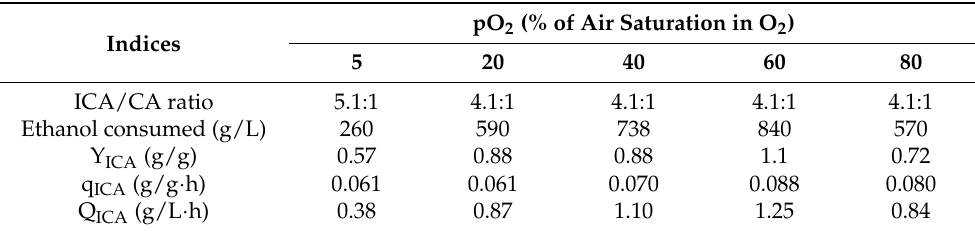
Table 5. Effect of aeration on indices of ICA production by Y. lipolytica VKM Y-2373. Indices